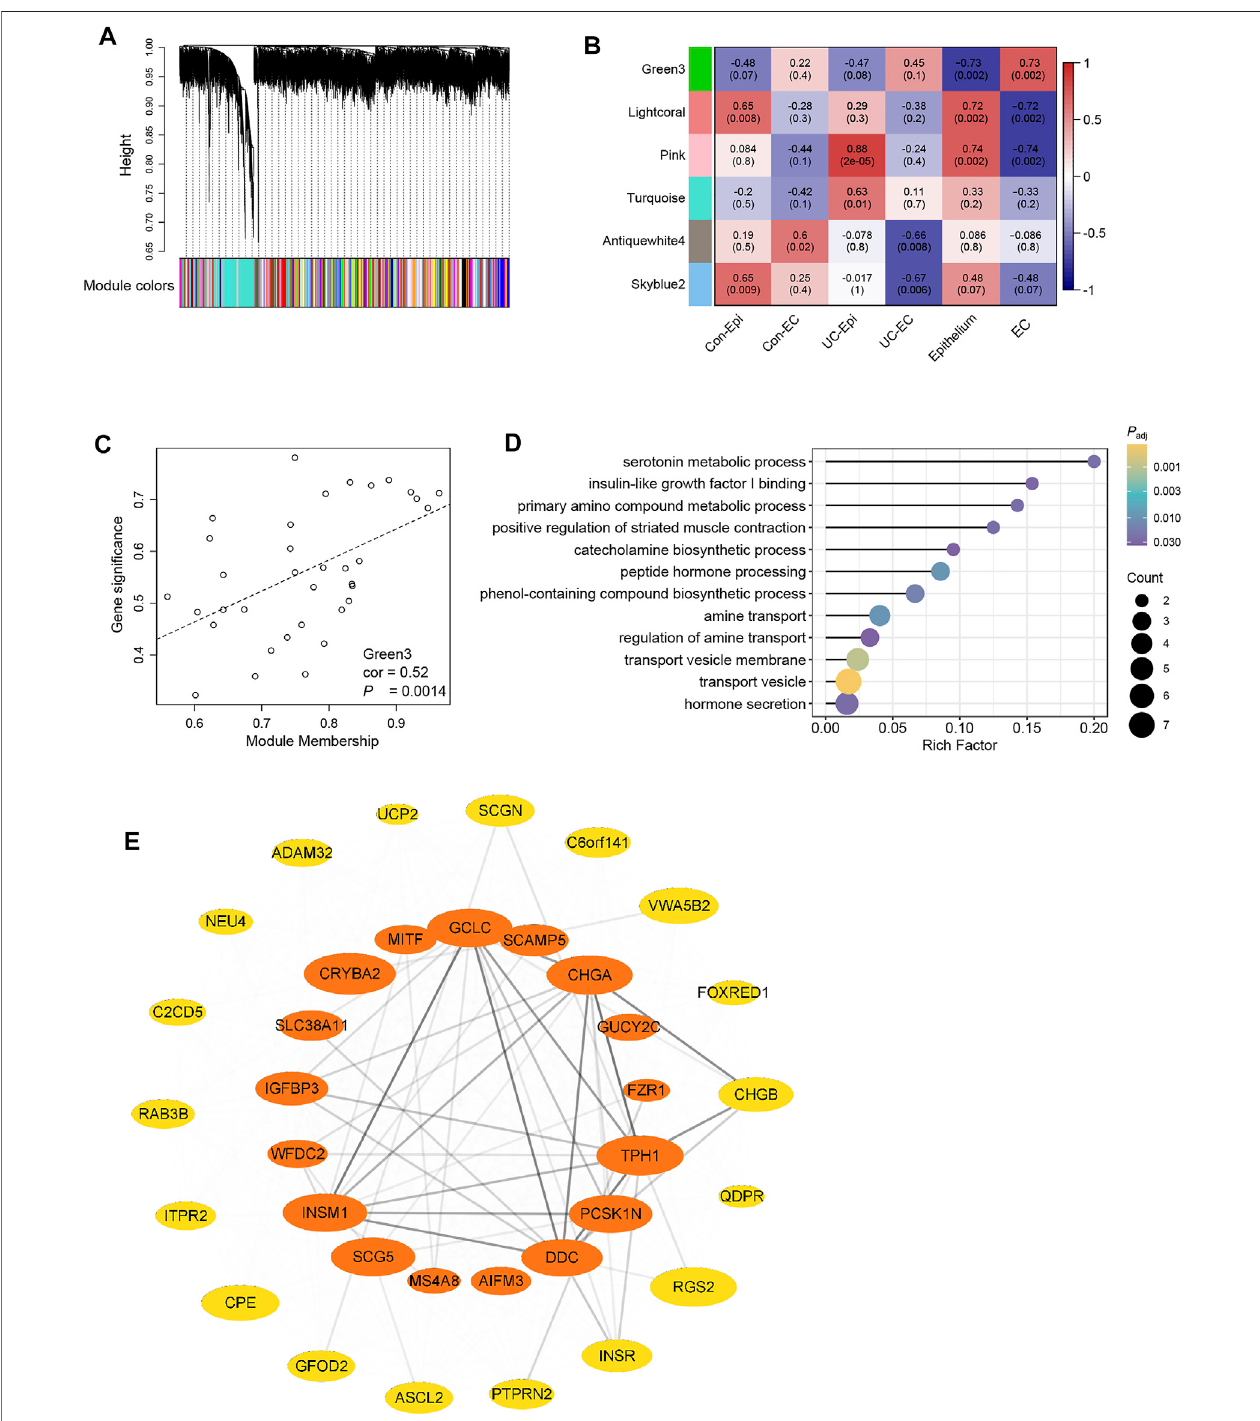
FIGURE 3 | Identi fi cation of coexpression networks and hub genes of EC cells using WGCNA. (A) Cluster dendrogram of 149 coexpression modules detected by WGCNA. The color row underneath the dendrogram shows the module assignment determined by the dynamic tree cut (B) Associations between coexpression modules and sample parameters (group and cell type). Module names are represented by colors. The upper number in each block is the correlation coef fi cient, and the lower number in parentheses is the p -value. Only modules with at least one signi fi cant association ( p -value < 0.05) were shown. (C) Correlations between module membershipandgenesigni fi canceweightforgenesintheGreen3module,indicatingthathubgenesoftheGreen3modulealsotendtobehighlycorrelatedwithweight. cor, correlation; P , p -value. (D) Overrepresentation analysis (ORA) ofgenesinthe Green3 module, analyzed using GOterms. Sizeoftherounds indicates genecount for each term, whereas the color indicates the P adj (adjusted p -value) of each term. (E) Coexpression network of the genes in Green3. Orange indicates hub genes for EC cells; the other genes are plotted in yellow. Ellipse size represents the weight of the gene in the network, and the transparency of lines between genes represents the strength of gene